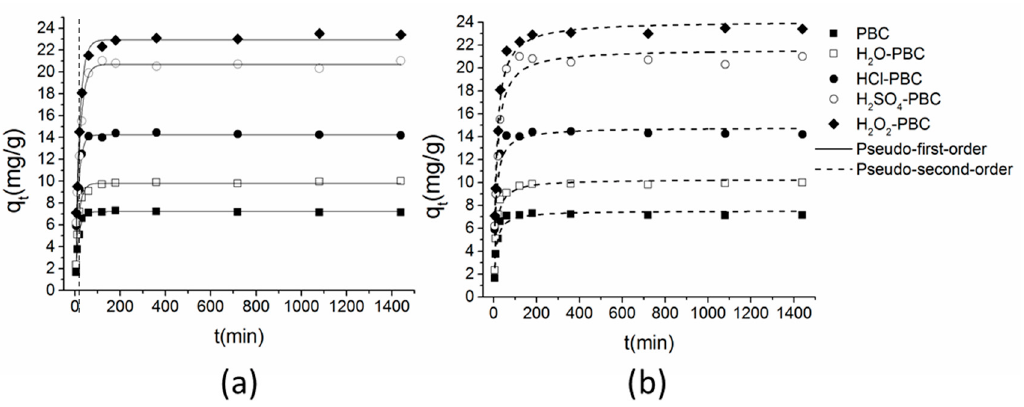
Figure 7. Adsorption kinetics of NH 4 + -N on the five kinds of biochar fitted with the pseudo-first-order ( a ) and pseudo-second-order models ( b ). Table 3. Kinetic parameters of the pseudo-first-order and pseudo-second-order equations for NH 4+ - N adsorption on the five kinds of biochar.